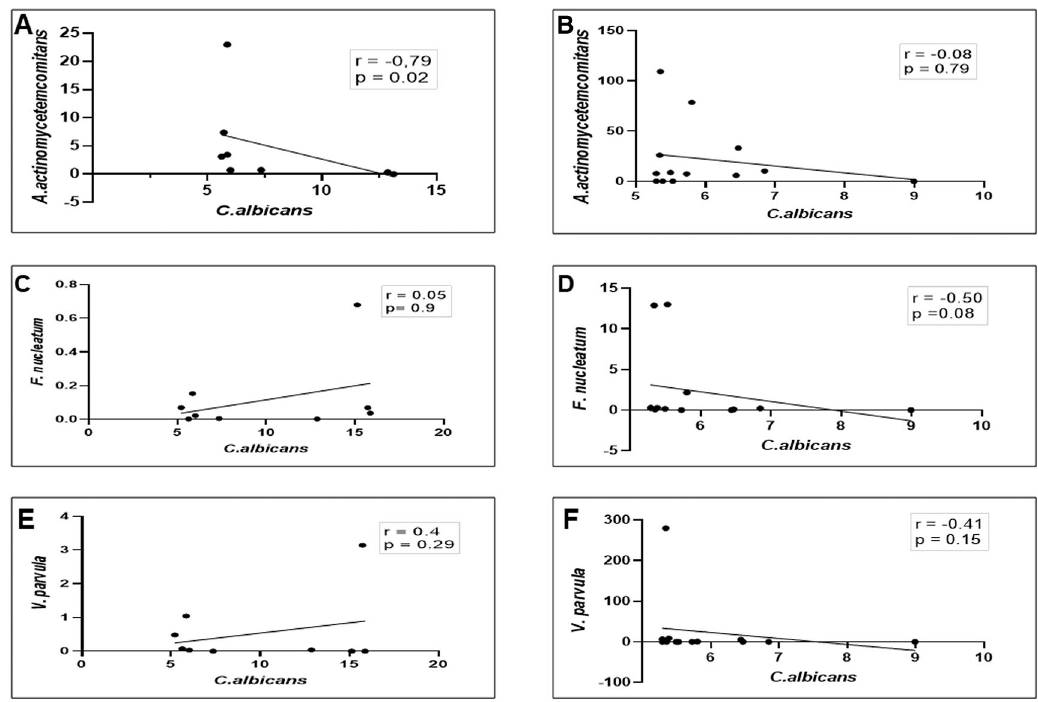
Figure 3. Relationship between the number (colony forming units/mL) of C. albicans ( Ca ) and the three gram- negative oral bacteria A. actinomycetemcomitans ( Aa ) , F. nucleatum ( Fn ), and V. parvula ( Vp ). In either patient group (DG or NDG), a strong negative correlation is consistently seen between Ca and Aa (A and B), while the other twobacteriashowaweakpositive inDG(Cand E)andnegativecorrelationsin NDG,respectively(DandF).Spearman correlation coefficient (r 2 ) and exact p-values are given.